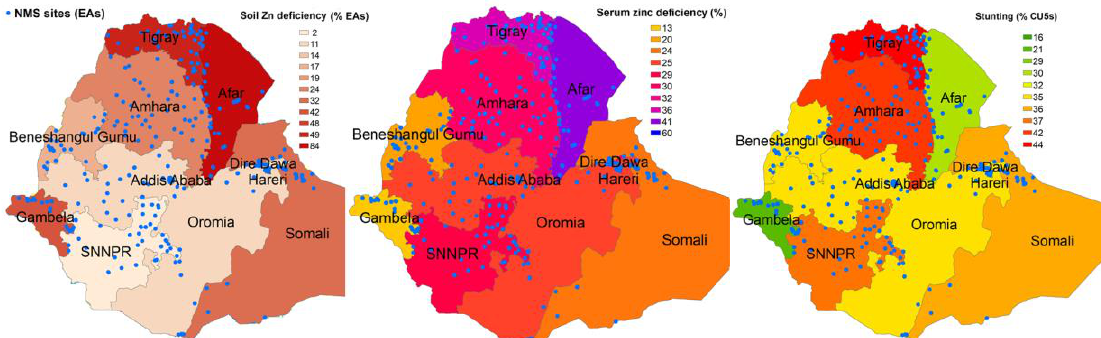
Figure 2. Geographical distribution of poor soil zinc, poor serum zinc status and poor linear growth of children in Ethiopia. NMS=National Micronutrient Survey; EAs = Enumeration Areas; Serum zinc deficiency (%) = Percent of under-five children who are deficient as measured by serum zinc; CU5s = children under five.